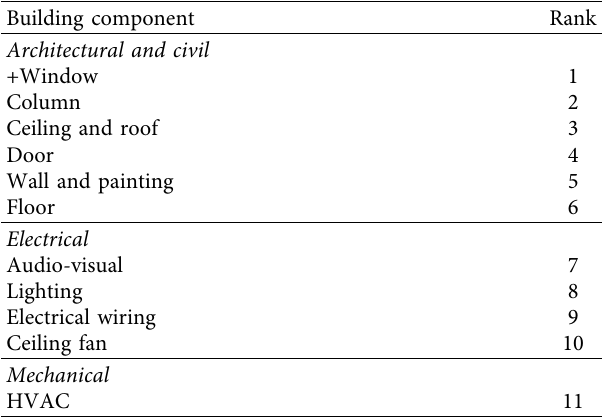
Table 12: Proposed priority hierarchy of building components for maintenance at Anglican churches in